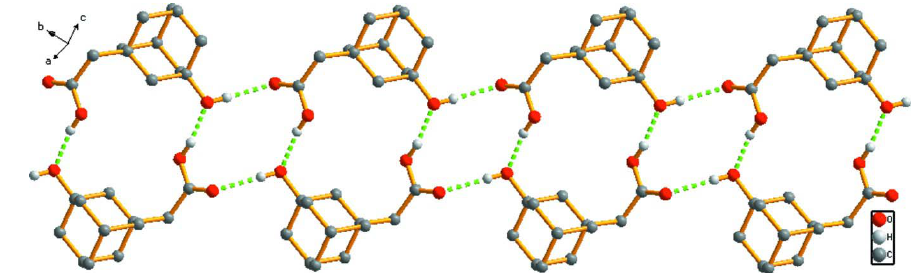
A view of the molecule of (I), showing the atom-labelling scheme. Displacement ellipsoids are shown at the 30% probability level.